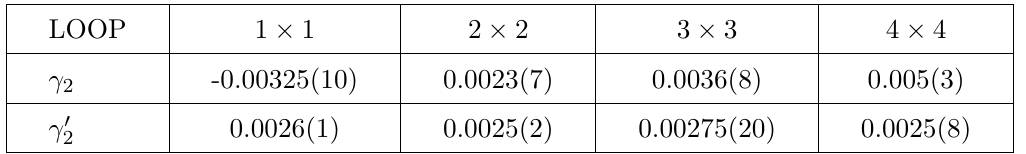
entering in the large L expansion of the function F 2 2